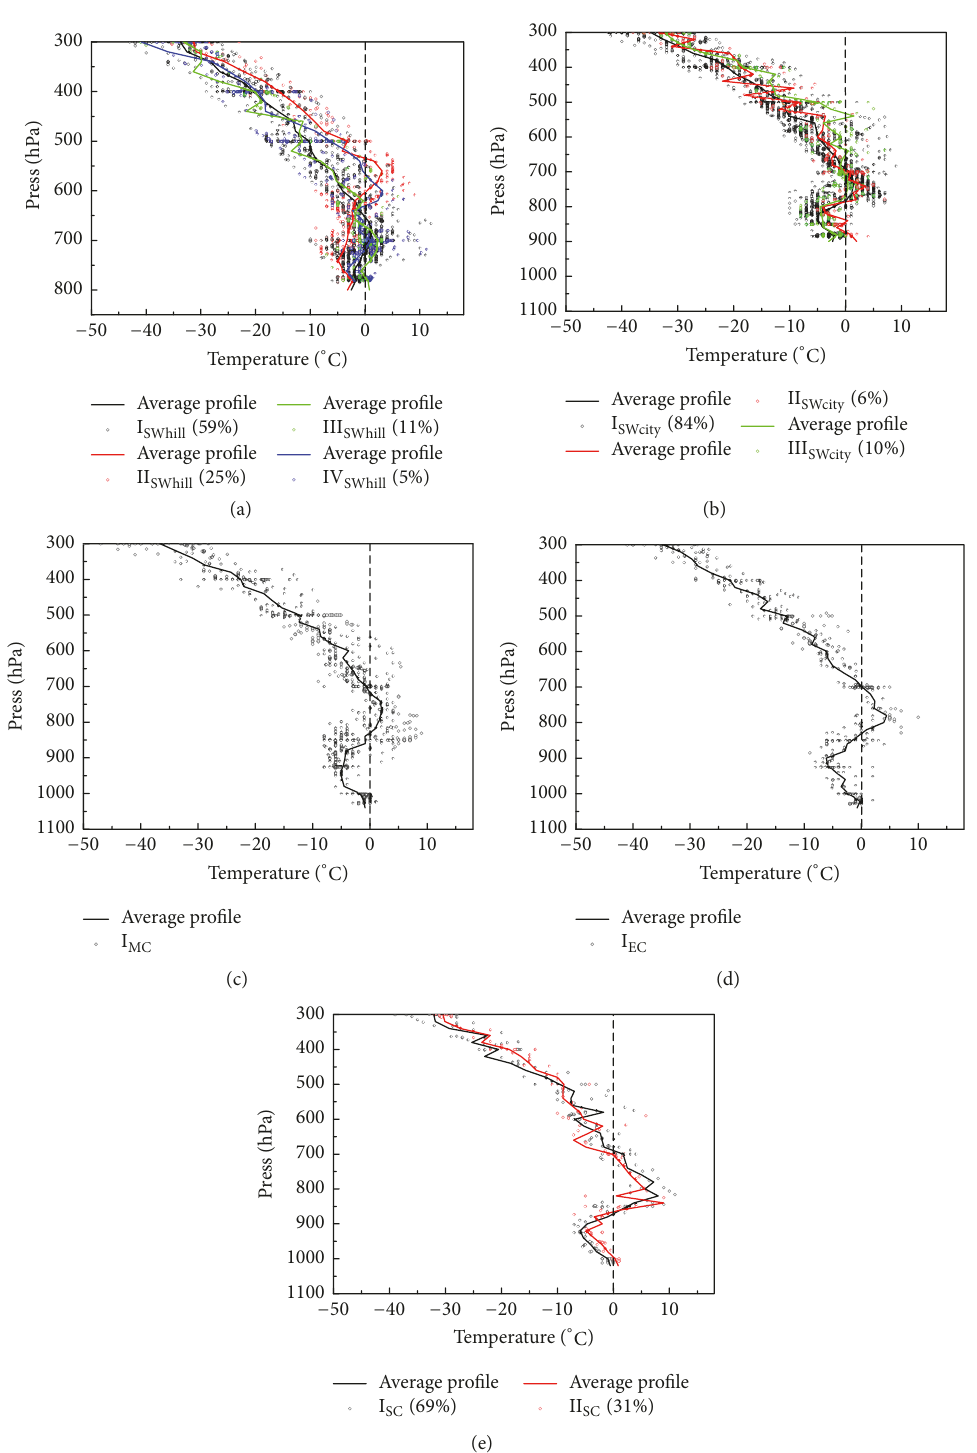
Figure 4: Distributions of mean temperature profiles during freezing rain events in China. (a) Mountainous area of Southwest China; (b) urban area of Southwest China; (c) Central China; (d) East China; (e) South